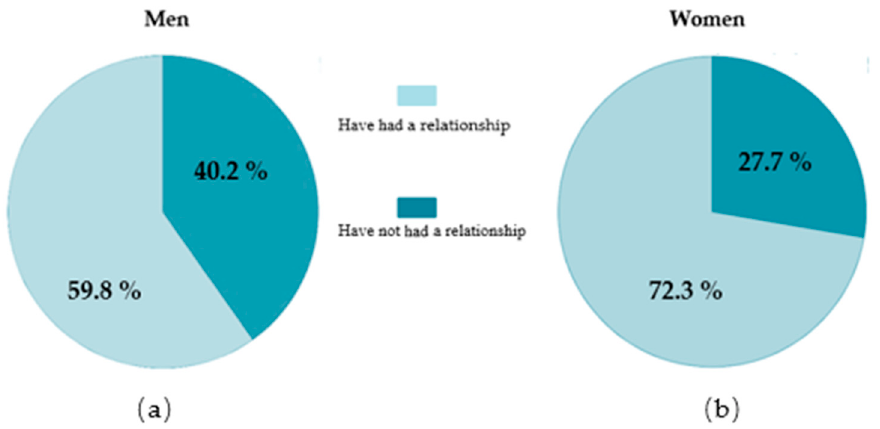
Figure 1. Percentage of adolescents who have had/have a dating relationship according to sex. ( a ) Percentage of male adolescents who have had/have a dating relationship; ( b ) Percentage of female adolescents who have had/have a dating relationship.